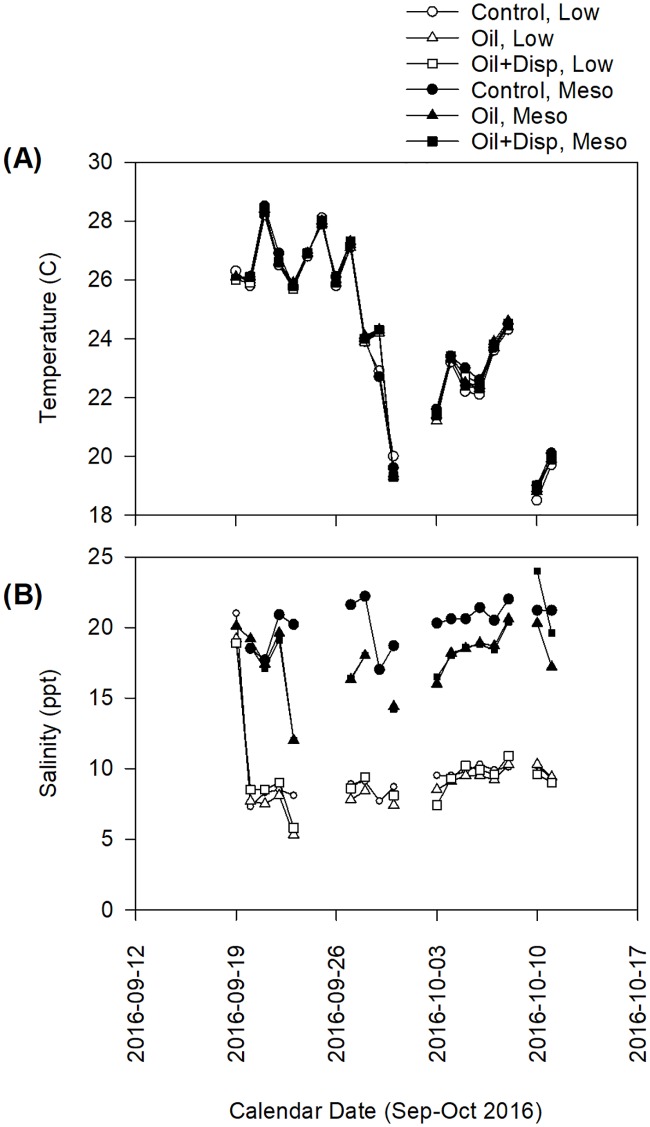
Temperature and salinity in experimental tanks.Time series analysis of (A) temperature and (B) salinity for the duration of the 21-d multi-stressor mesocosm experiment. Dates are formatted as year-month-day.